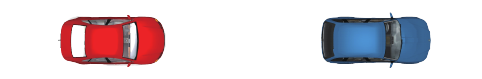
Figure 3. The safe distance for lane-keep